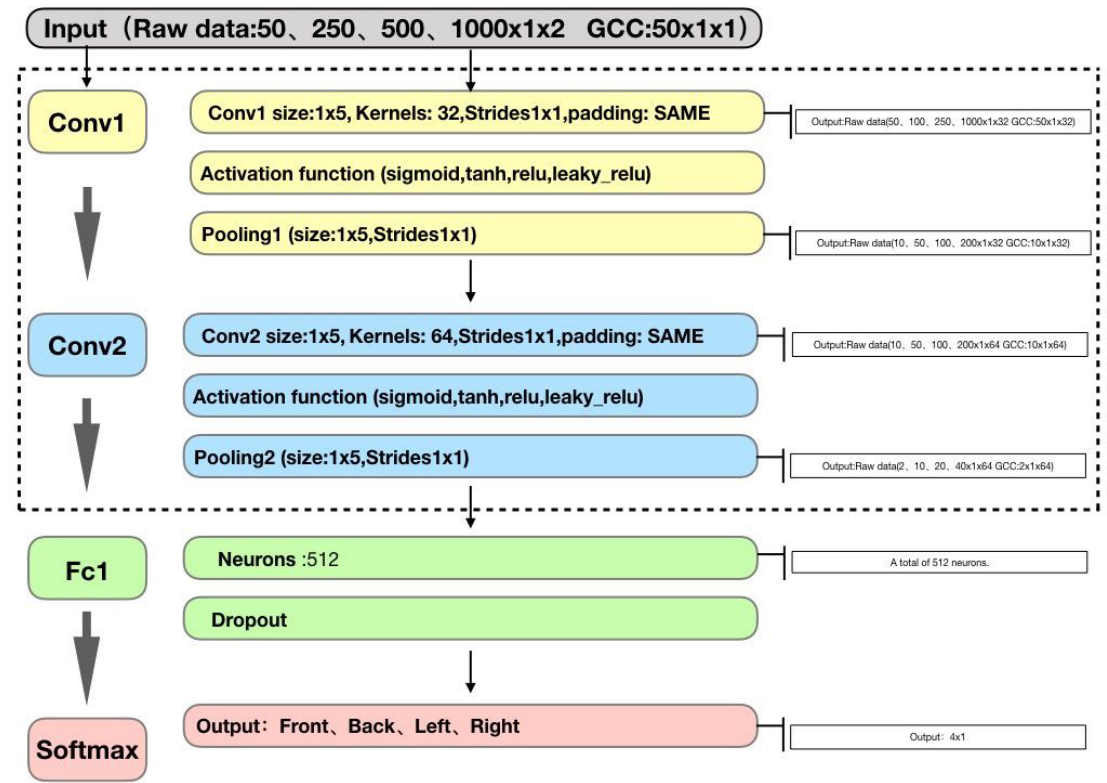
Figure 5: Schematic diagram of the convolutional neural network structure. Net1 contains two convolutional layers, while Net2 contains only one convolutional